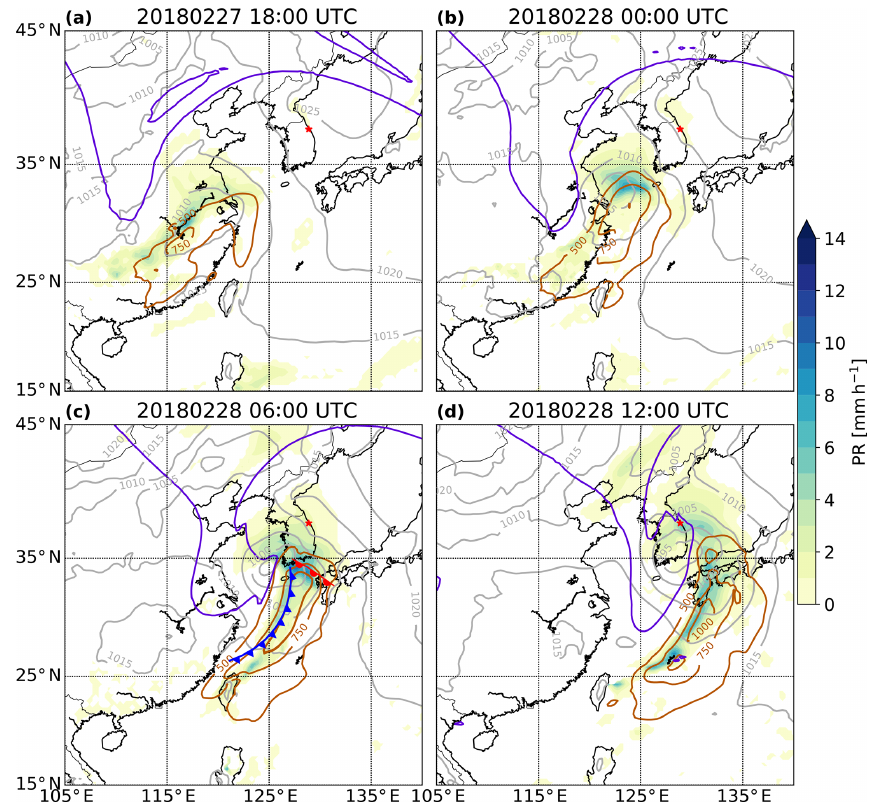
Figure 2. Sea level pressure (grey contours, labels in hectopascals), dynamical tropopause on the 315K isentrope (purple lines), IVT (brown contours, labels in kilograms per metre per second; only values greater than 500kgm − 1 s − 1 are shown) and precipitation rate (PR) in mil- limetres per hour (colour-filled) at (a) 18:00UTC on 27 February 2018 and (b) 00:00UTC, (c) 06:00UTC and (d) 12:00UTC on 28 Febru- ary 2018 from ERA5 data. The warm and cold fronts at 06:00UTC were manually drawn based on an analysis of equivalent potential temperature at 850hPa. The red star shows the location of